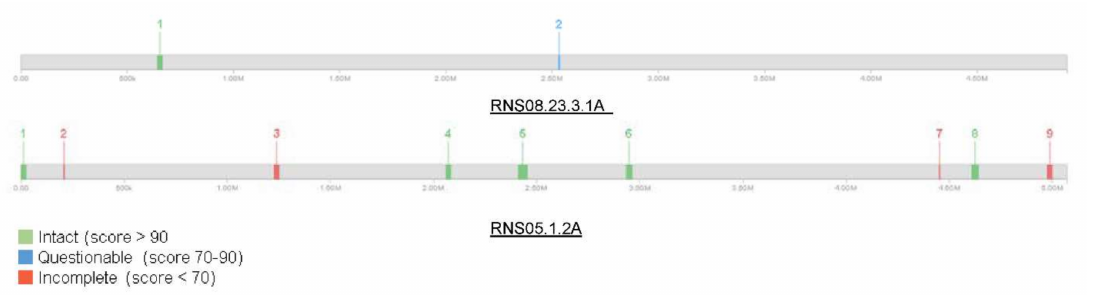
Figure 2. Graphical representation of phage distribution in D. solani strains RNS05.1.2A and